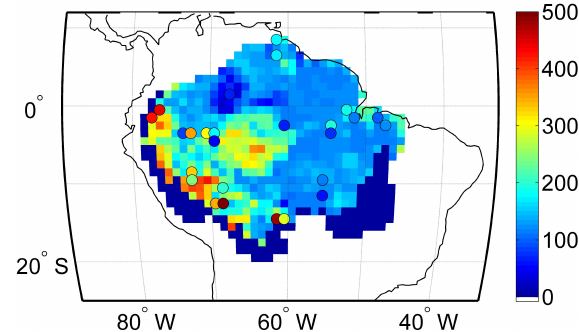
Fig. 4. Estimated total soil phosphorus map in mgkg − 1 (average depth from 0 to 0.3m). The dots represent averaged field plot mea- surements in one-degree grid cells (Quesada et al., 2010). The total soil phosphorus map (background) is derived based on soil class map and the relationship between site level total soil P content and soil class (Fig.